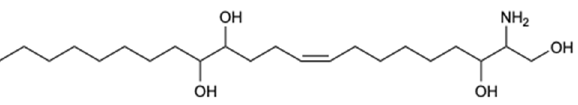
Figure 10. Structure of haliscosamine ( 37 ).